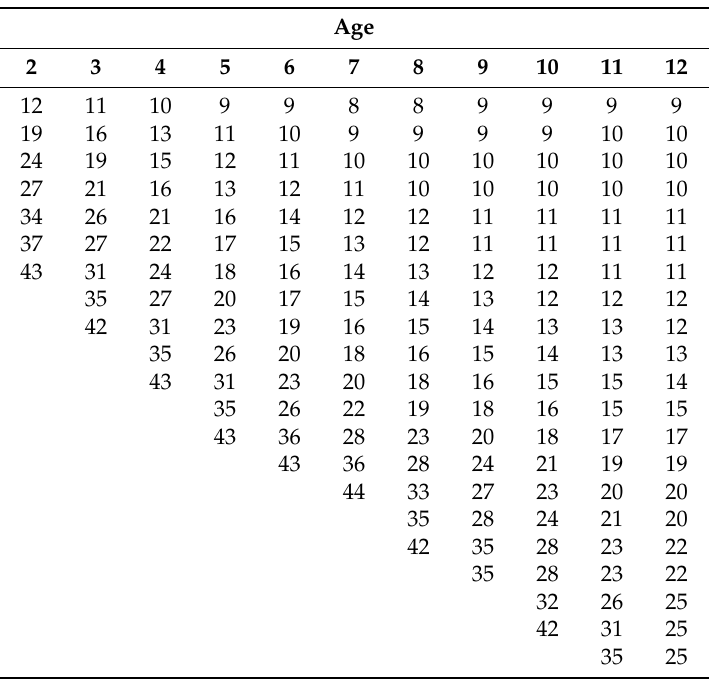
Table 5. Health/Physical/Behavior subscale score norms as a function of the initial score and age from Figure